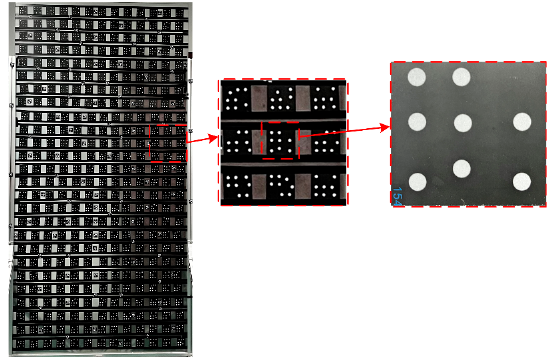
Figure 9. The planar calibration target used in the experiments.